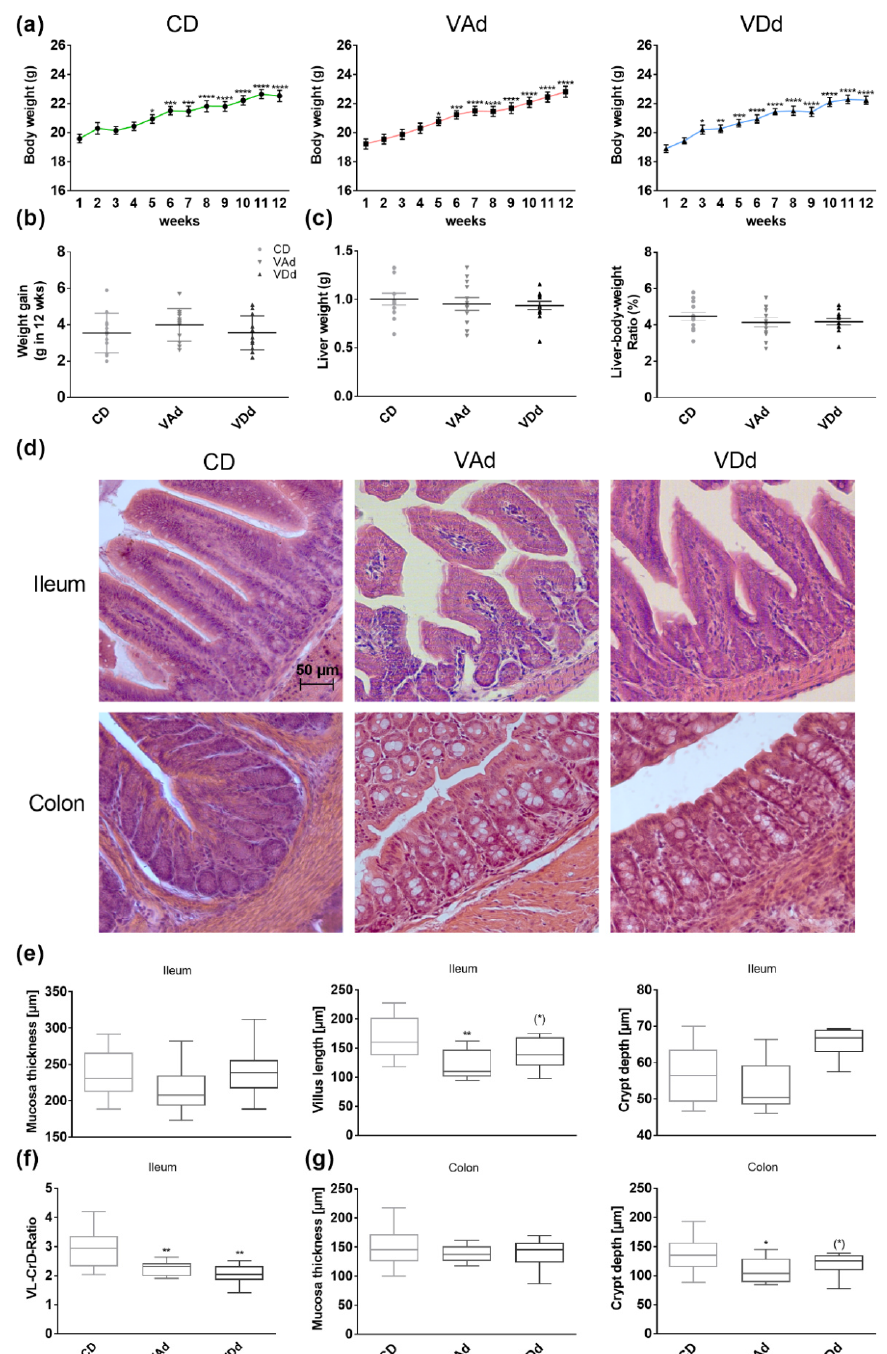
Figure 1. Vitamin-deficient fed mice exhibit morphological changes in the gut. Weight development during 12-week feeding period ( a ). Weight gain in g after 12-week feeding period ( b ) and hepatic markers: liver weight and liver to body weight ratio in percent ( c ) are shown. Representative images of HE staining in ileal and colonic tissue. Scale bar: 50 µm ( d ). Quantification of the mucosa thickness, villus length and crypt depth in ileum ( e ), ileal ratio of villus length to crypt depth ( f ) and of mucosa thickness and depth of the crypts in colon ( g ). Data are presented as means +/ − standard error of the mean ( n = 8–12). Statistical analysis was performed by one-way ANOVA with Sidak´s post-test. Significant differences are indicated: * p -value < 0.05; ** p -value < 0.01; *** p -value < 0.001; **** p -value < 0.0001. Abbreviations: CD, control diet; CrD, crypt depth; VAd, vitamin A-free diet; VDd, vitamin D-free diet; VL, villus length.